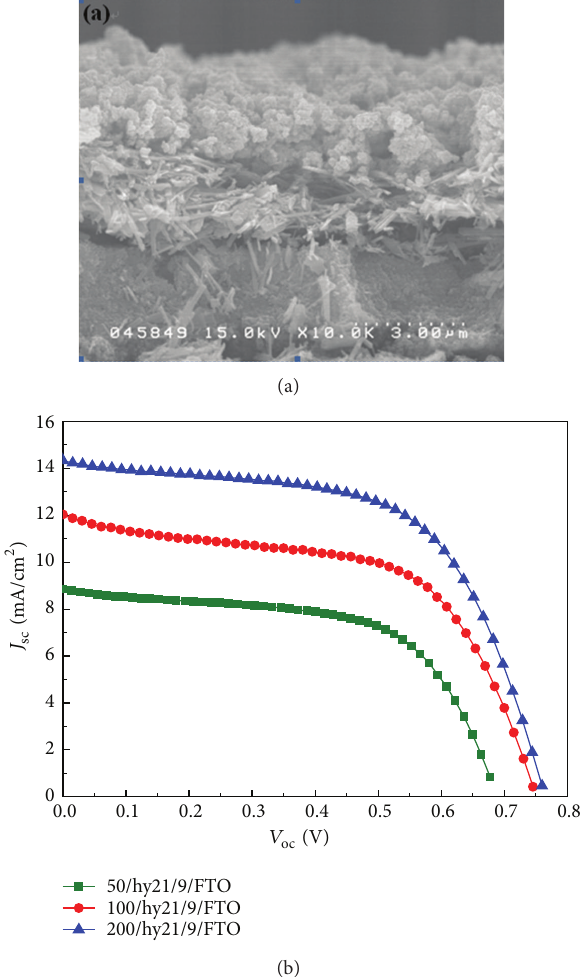
Figure 8: (a) The cross-section scanning electron microscopy (SEM) images of TiO 2 thin films with triple layer structures. (b) 𝐼 - 𝑉 curveofdye-sensitizedsolarcellswithtriplelayerstructuresof TiO 2 thin